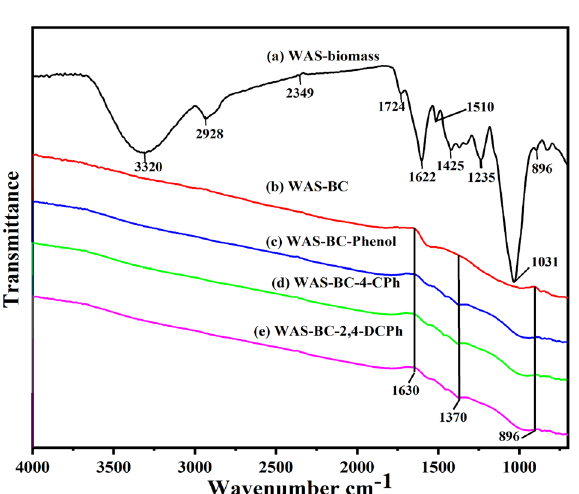
Figure 2. FT-IR spectra of (a) WAS-biomass, (b) WAS-BC, (c) WAS-BC-phenol, (d) WAS-BC-4-CPh, and (e)